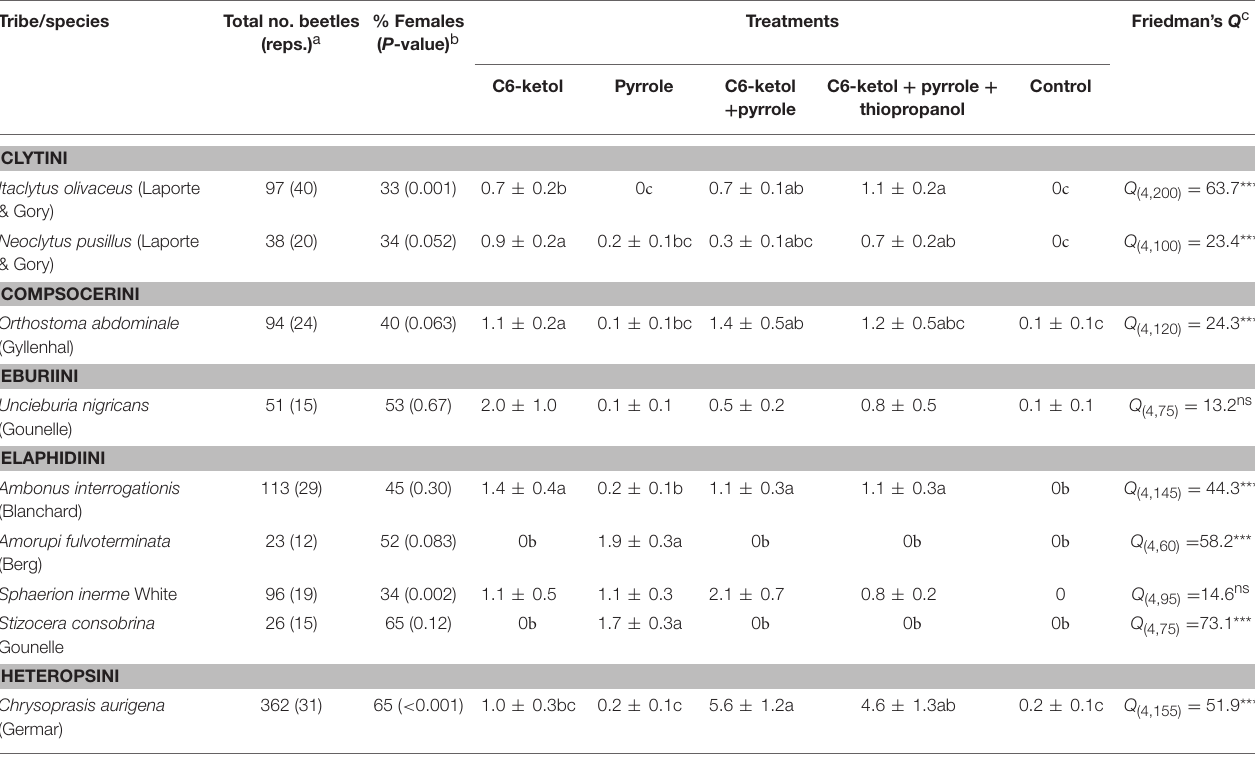
TABLE 1 | Mean ( ± 1 SE) number per replicate of adults of other cerambycid species in the subfamily Cerambycinae that were caught in the field bioassay of possible attractant pheromones produced by males of Ambonus distinctus and Ambonus electus .